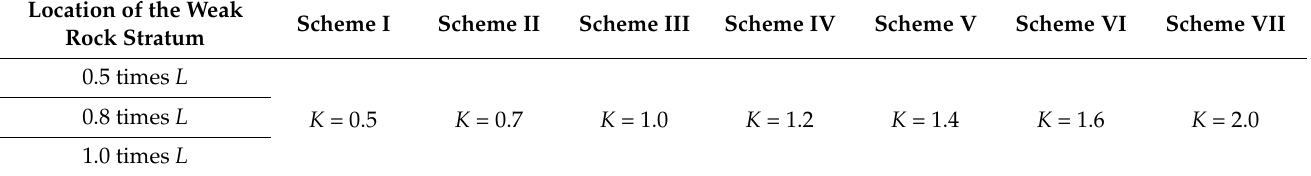
Table 4. Scheme Settings of the Model.